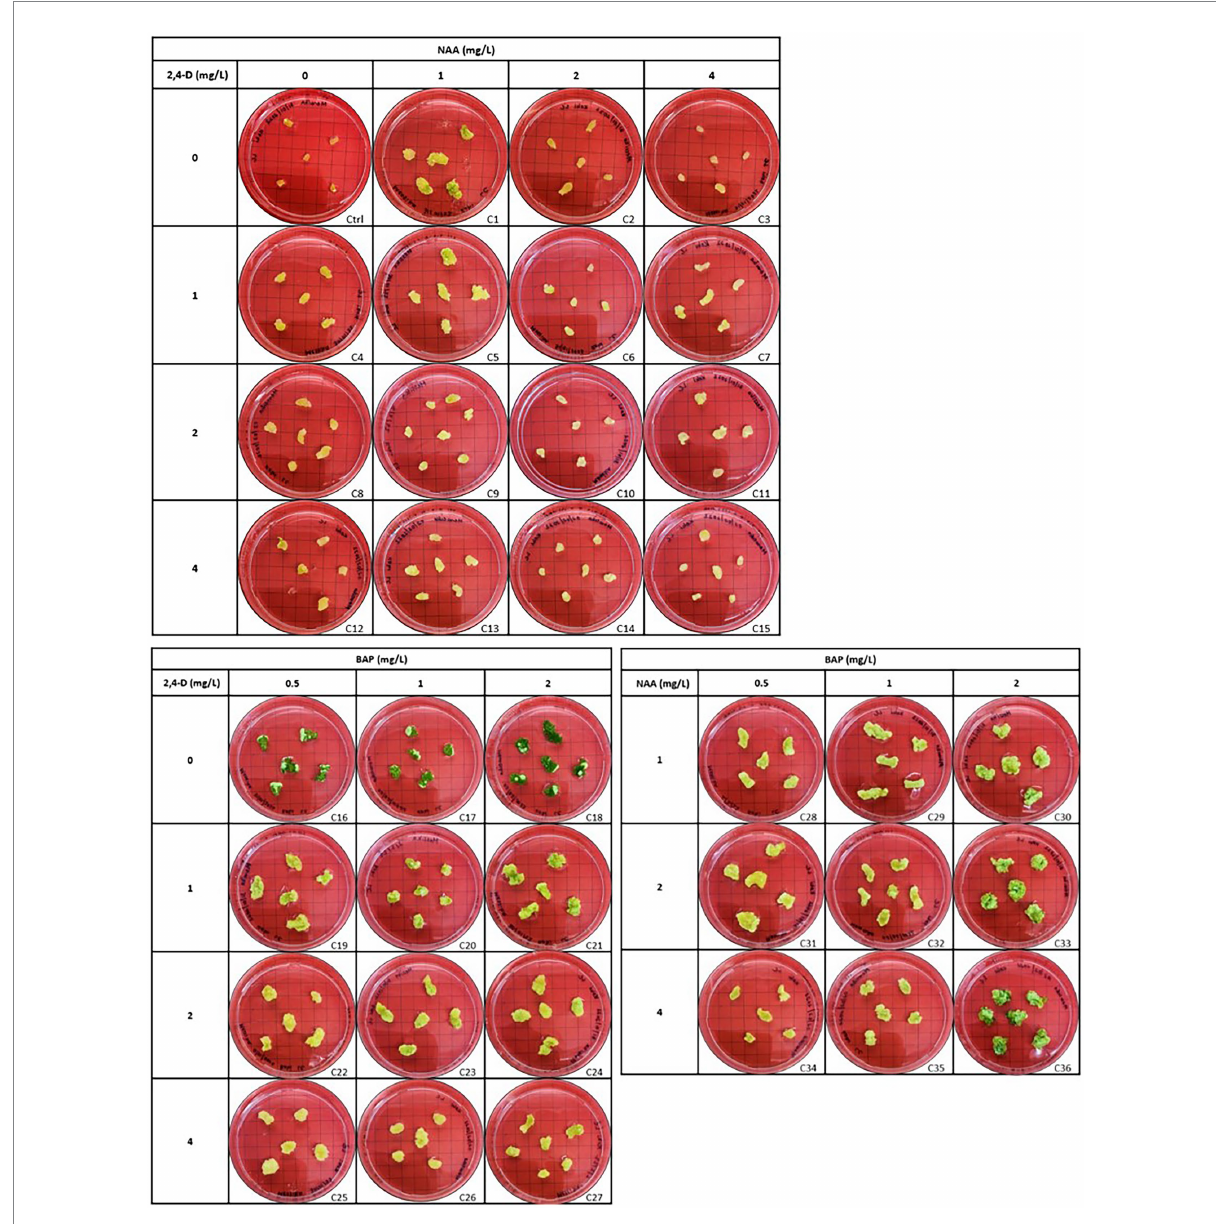
FIGURE 4 Morphogenic response of leaf explants in different concentrations and combinations of 2,4-D (2,4-Dichlorophenoxyacetic acid), NAA (1-Naphthaleneacetic acid) and BAP (6-Benzylaminopurine) 45 days after initiation. Each treatment was replicated 10